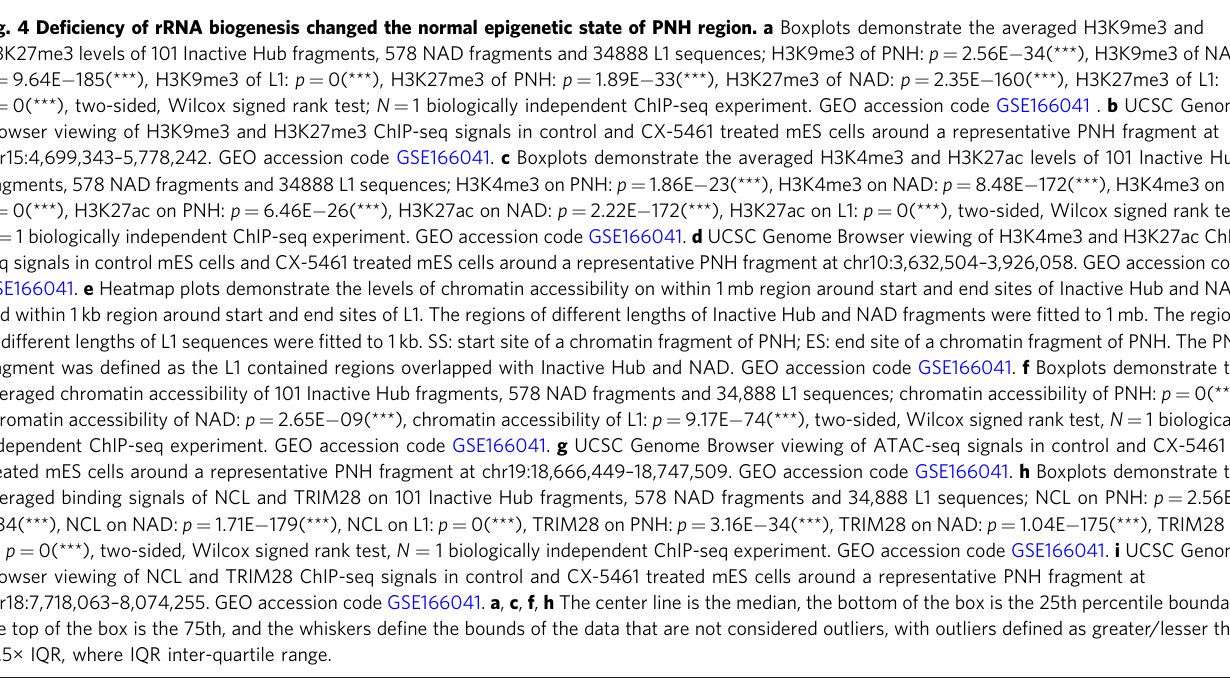
Fig. 4 De fi ciency of rRNA biogenesis changed the normal epigenetic state of PNH region. a Boxplots demonstrate the averaged H3K9me3